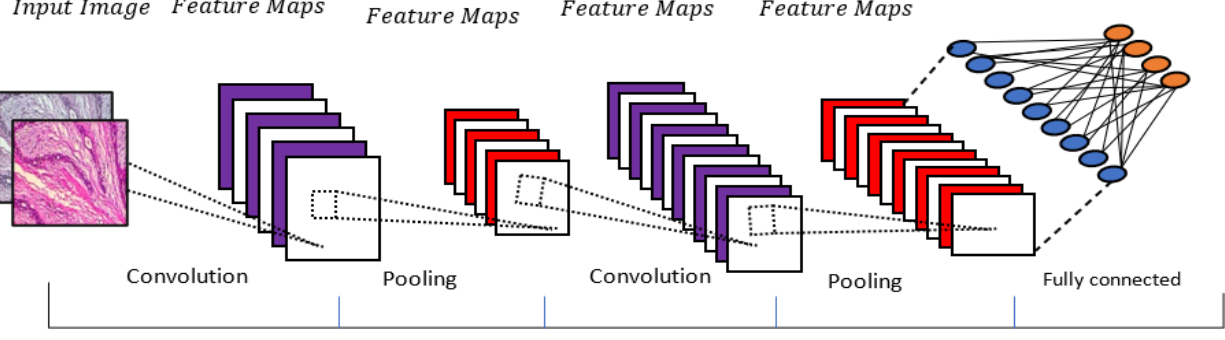
Figure 2. An illustration of the deep autoencoder.